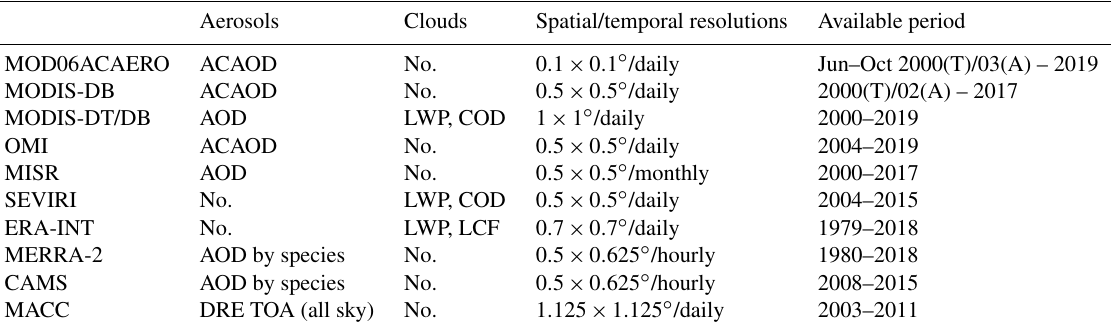
Table 2. Satellite (T: Terra, A: Aqua) and reanalysis data used in this study to analyze aerosols’ and Sc clouds’ microphysical/optical properties. Aerosols Clouds Spatial/temporal resolutions Available